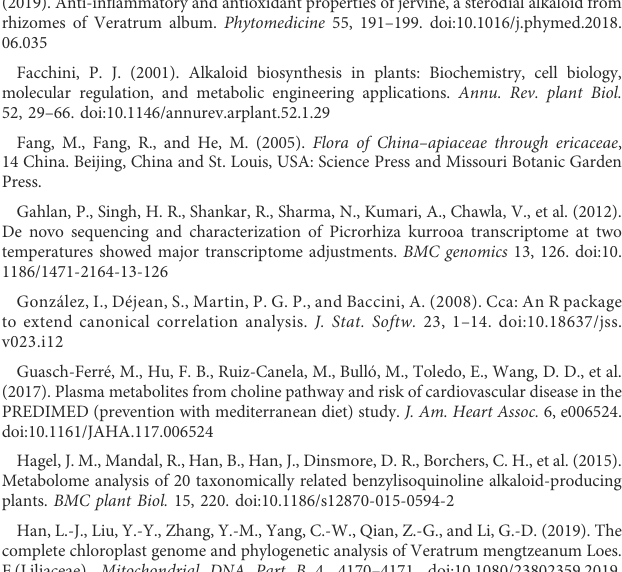
SUPPLEMENTARY FIGURE S8 The cluster heatmap of differentially accumulated metabolites (DAMs), particularly alkaloids found in the leaves and roots of V. mengtzeanum exhibits a fold change of top signi fi cant ( p < 0.05). The X-axis represents the sample names, and the Y-axis indicates the differential metabolites. Distinct colors in the heat map represent the values obtained after the normalization of the relative content of the differential metabolite, re fl ecting the level of their relative content (red: represents higher